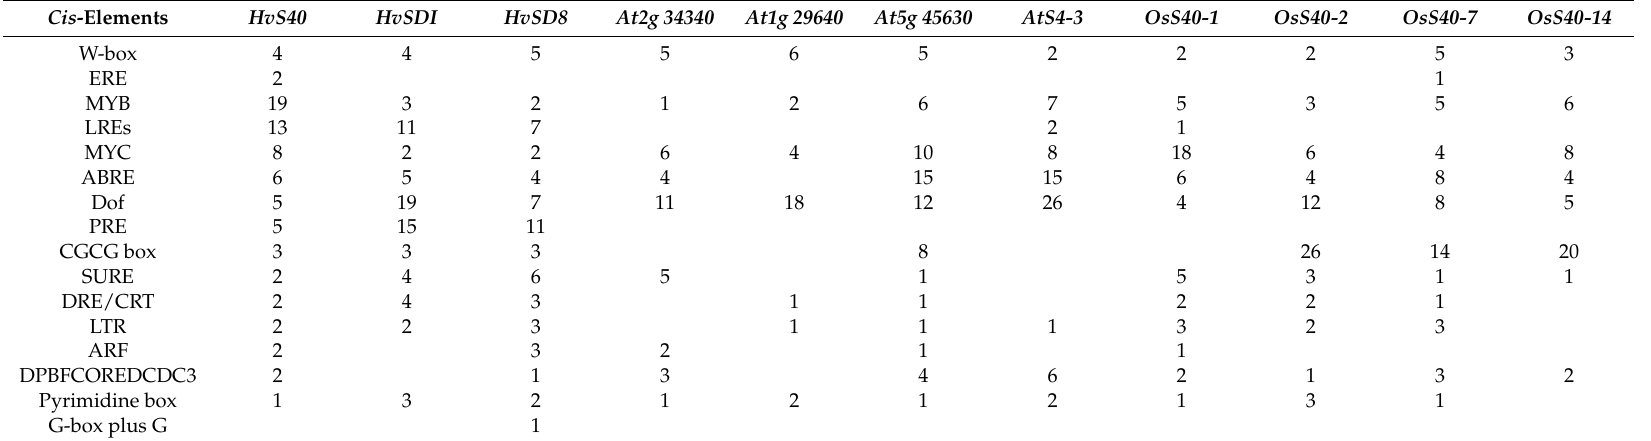
Table 3. Cis -elements in the promoters of S40 genes in barley, Arabidopsis, and